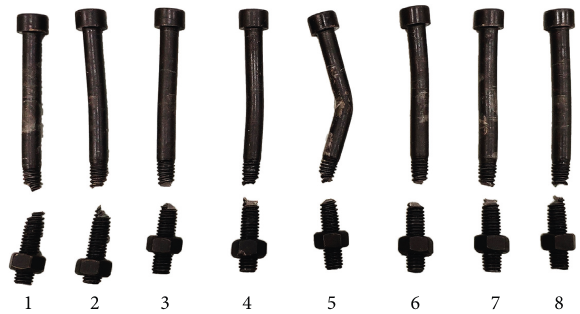
Figure 10: The experimental results of the